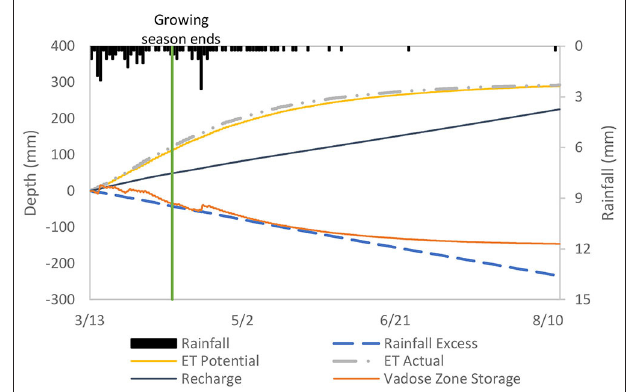
FIGURE 6 | Cumulative overland flow quantities for the Chididimo watershed during S1, the base